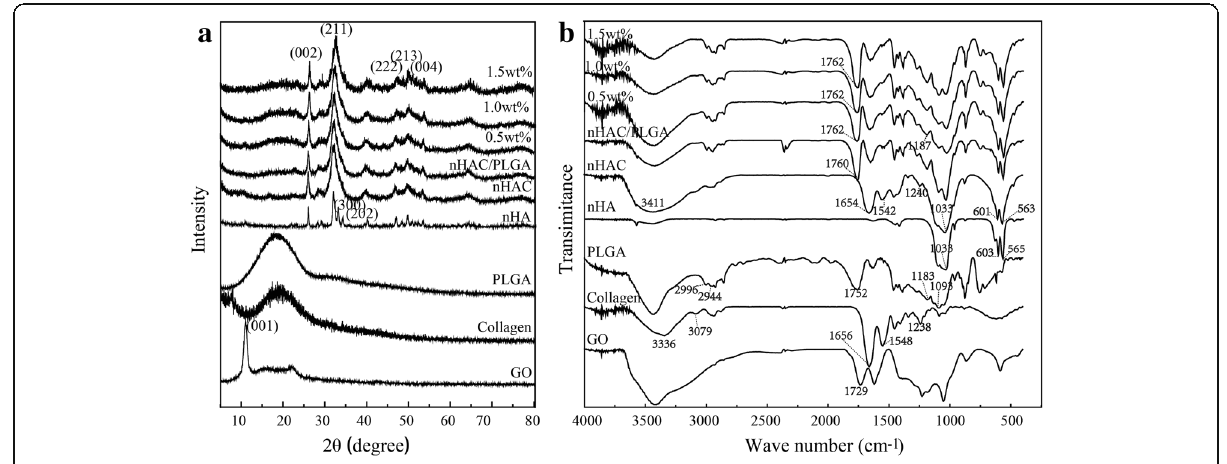
Fig. 3 a XRD and b FT-IR spectra of different